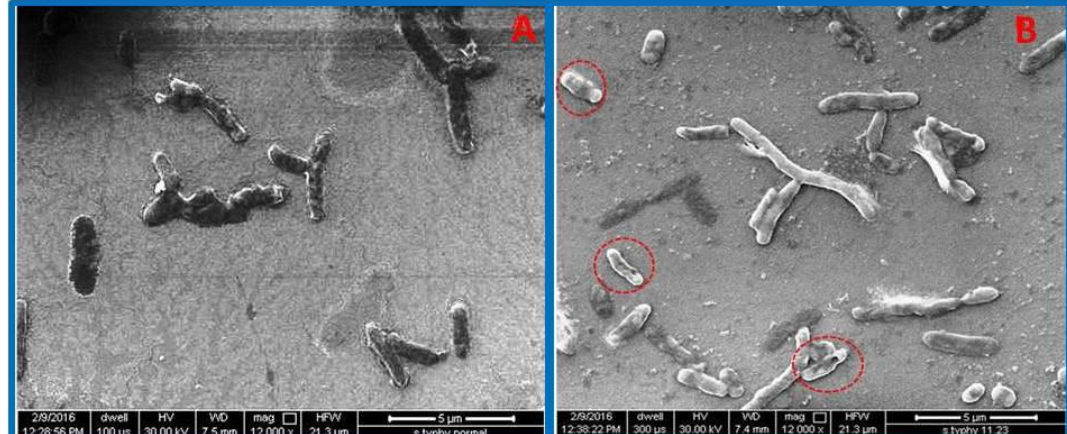
Figure 5: The image represents the normal S. Typhi (A) and treated S. Typhi with silver nanoparticles (B)